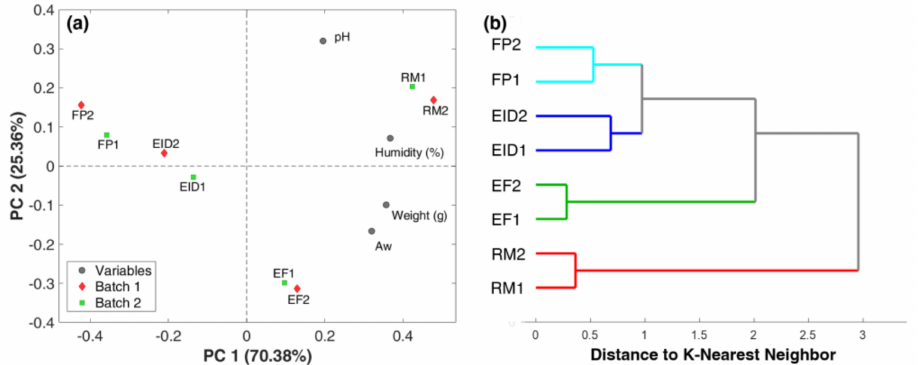
Figure 4. Physicochemical results: ( a ) biplot of Principal Component Analysis and ( b ) dendrogram of cluster analysis by K-nearest neighbor. Raw material, RM; end of fermentation, EF; end of intense drying, EID; and final product,